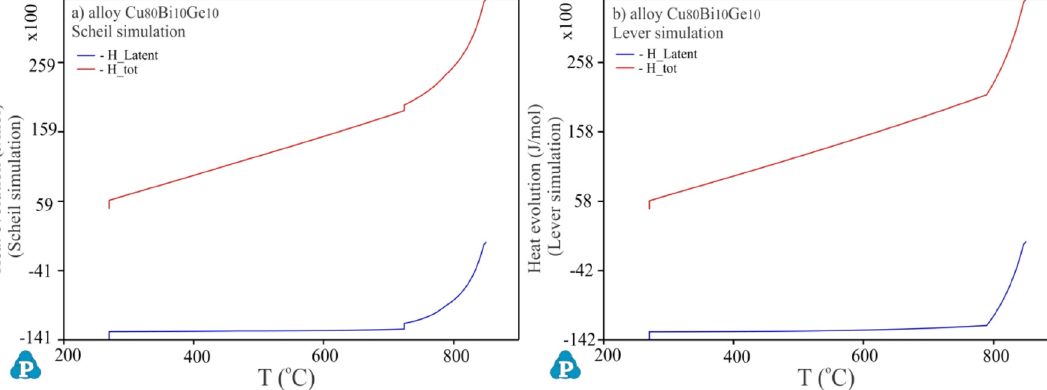
Bi Ge , a) Scheil simulation and b) Lever 80 10 10